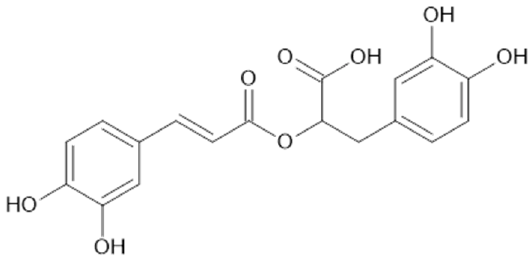
Figure 19. Chemical structure of compound 87 (MW = 360). Denev et al. reported that the aerial parts of A. glabra contained 73 , 74 , 3,4-dihydroxybenzoic acid ( 76 ), and 79 [32]. In the leaves, including stalks, of A. vulgaris and A. mollis , three phenolic acids ( 74 , 77 , 79 ) were found [34]. Moreover, in different extracts from the aerial parts of A. mollis , 73 , 79 , and gentisic acid ( 80 ) were noticed [36]. In the 80% methanol extracts from the leaves of A. jumrukczalica and A. vulgaris (Bulgaria), free and bonded phenolic acids were identified. Among reported phenolic acids, 73 , 80 , protocatechuic ( 81 ), salicylic ( 88 ), trans -cinnamic ( 91 ), and vanilic ( 93 ) acids were the major compounds [43].